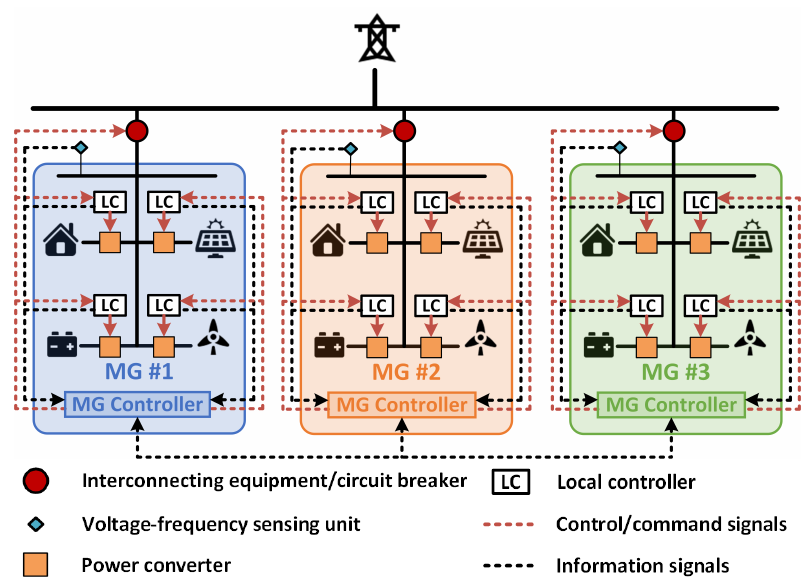
Figure 4. Distributed control